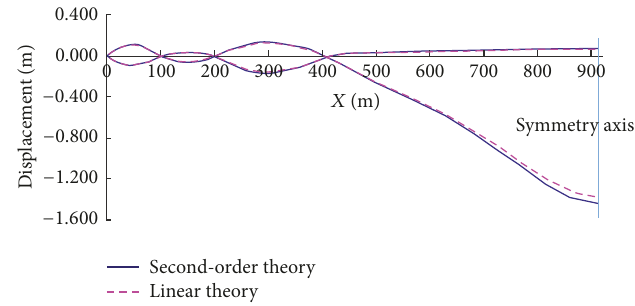
Figure 9: Envelope diagram of girder’s vertical